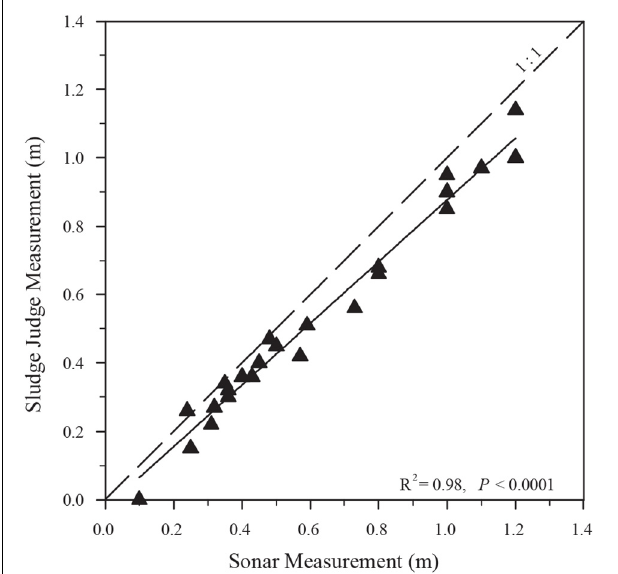
FIGURE 1 | Sonar vs. sludge judge measurement ( n = 24). The dashed line indicates the 1:1 relationship, with the relationship between sonar and sludge judge (solid line) being very close to ideal (Reprinted from Coggins et al., 2017, Page 357, Copyright (2016), with permission from Elsevier).